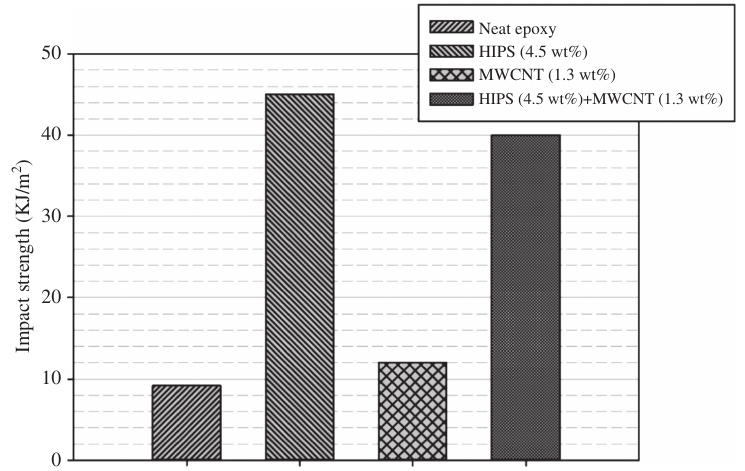
Figure 8 Impact strength of different